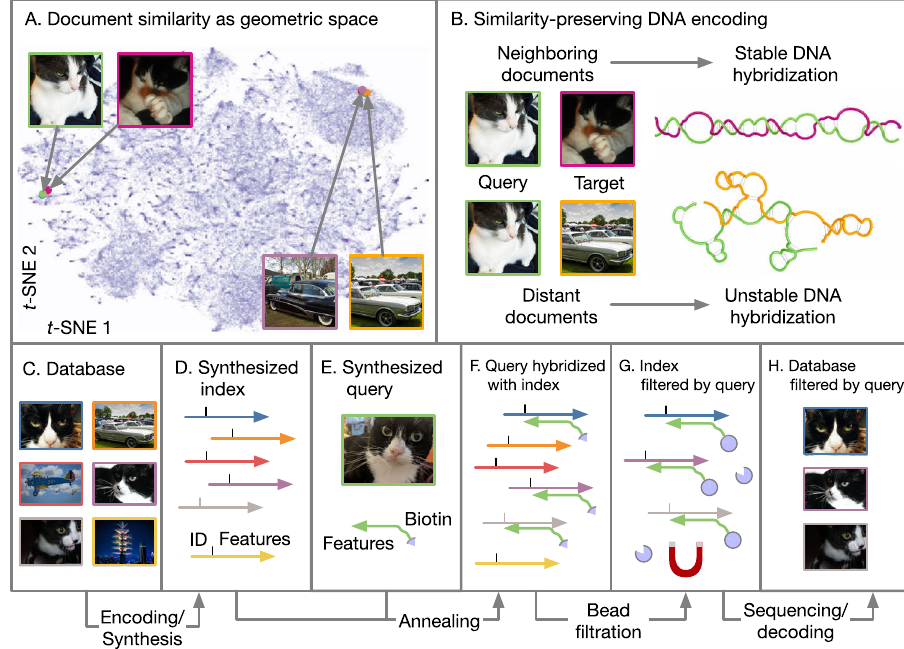
Fig. 1 Overview DNA-based similarity search. A Illustration of a feature space where neighboring documents are subjectively similar. B A similarity- preserving DNA encoding is one where the reverse complement of a query document ’ s sequence hybridizes with a neighboring target document ’ s sequence, but not with a distant target ’ s. Note that the query is color-coded green and the targets with other colors. C – H The retrieval process. A database ( C ) is encoded and synthesized to produce an DNA-based index ( D ). Arrowheads indicate 3 ’ ends of DNA. An encoded query ( E ) is annealed with a sample of the database ( F ), which is fi ltered with magnetic beads ( G ). The fi ltered database is sequenced to reveal the IDs of retrieved documents, which are used to look them up in the original database ( H